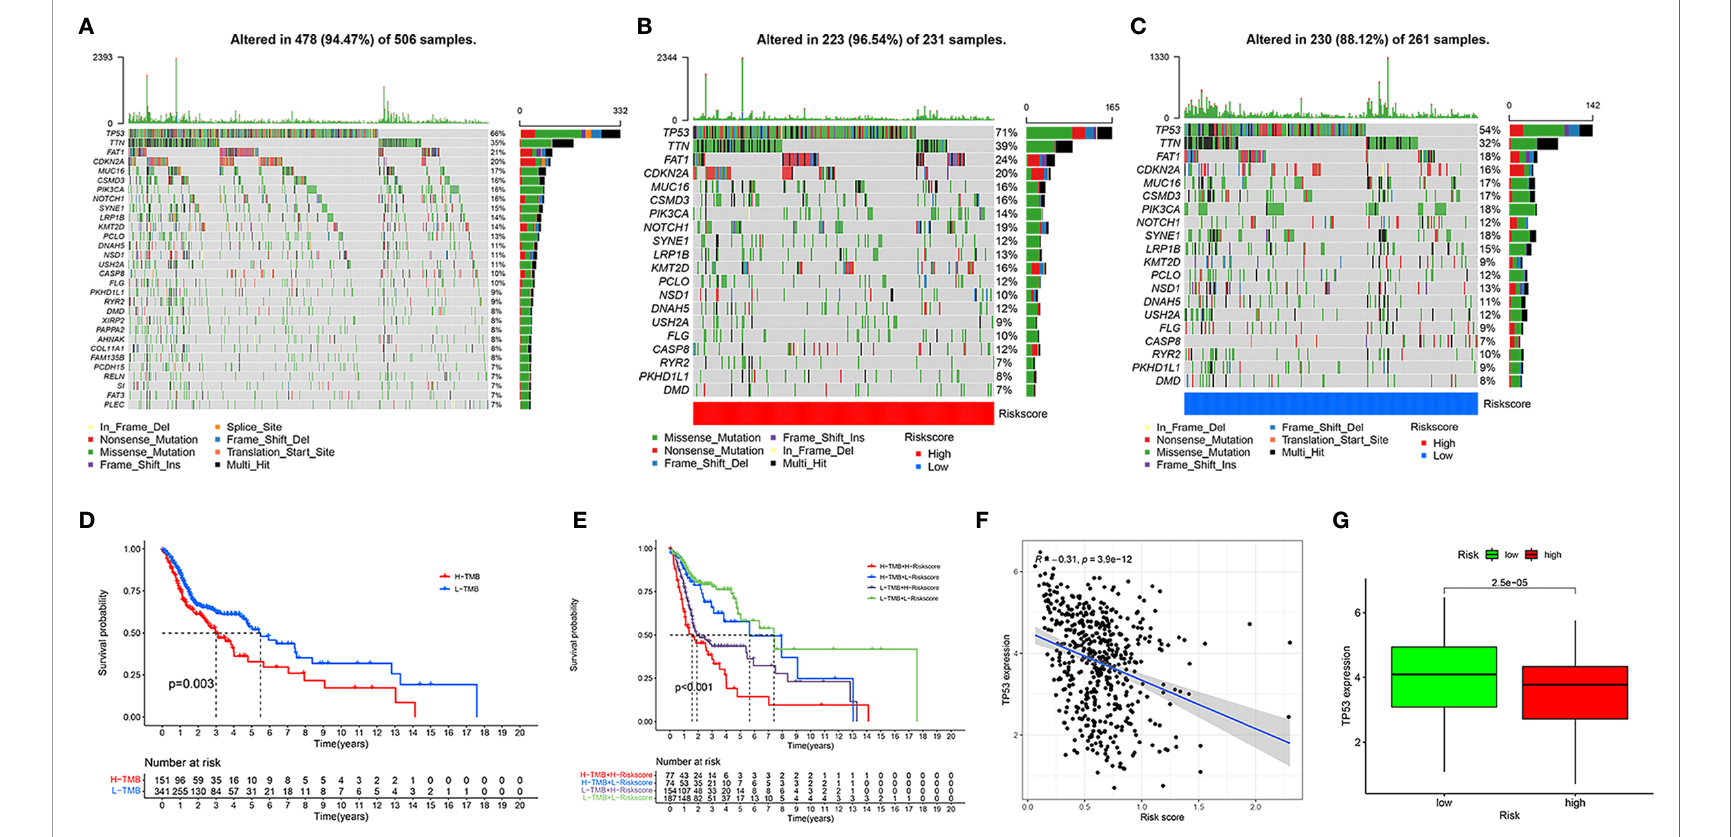
FIGURE 7 | Assessment of tumor mutation burden of HNSCC. Top 30 mutant genes of all HNSCC samples (A) . Top 20 mutant genes of high- (B) and low-risk (C) groups. Kaplan-Meier survival curve showing the OS differences between the high- and low-TMB groups (D) . Kaplan-Meier survival curve showing the OS differences in the four combinations of TMB and risk (E) . Correlation of TP53 expression and risk score (F) . Different expression of TP53 in high- and low-risk groups (G)